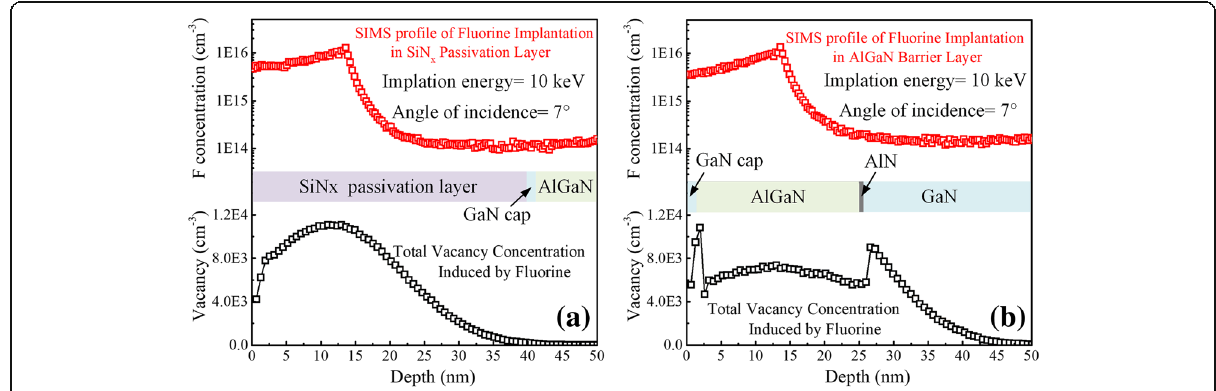
Fig. 2 Measured SIMS profile of fluorine ion concentration and simulated vacancy concentration by TRIM along the cut lines. a A-A ′ . b B-B ′